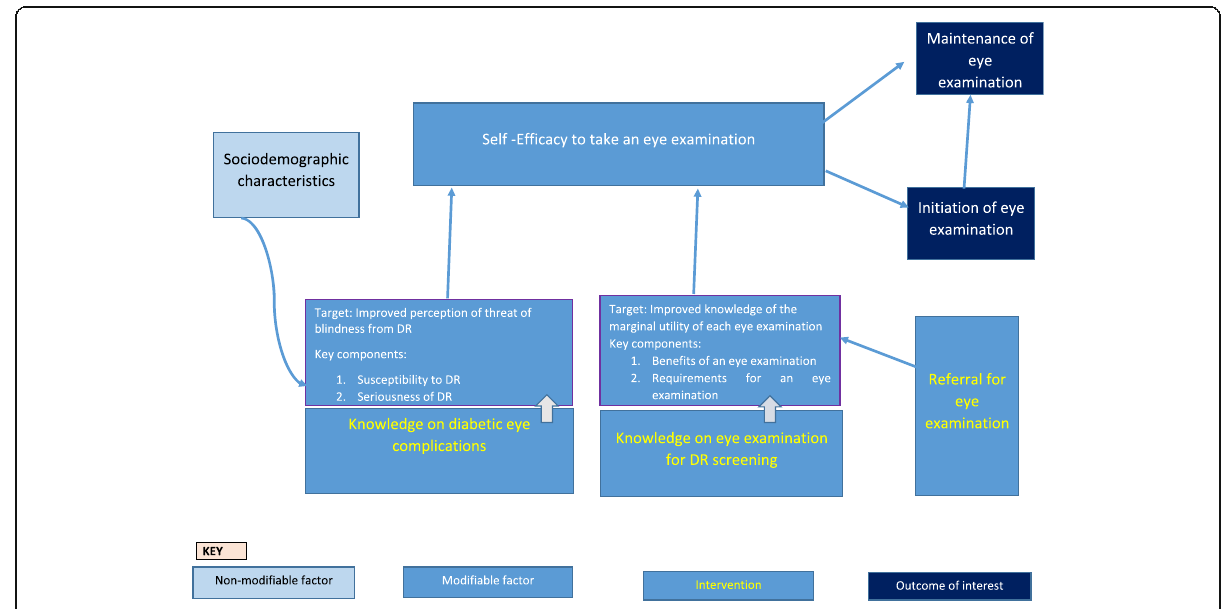
Fig. 1 A conceptual model on how interventions to strengthen knowledge of PLWD, referral and self-efficacy can improve uptake of eye